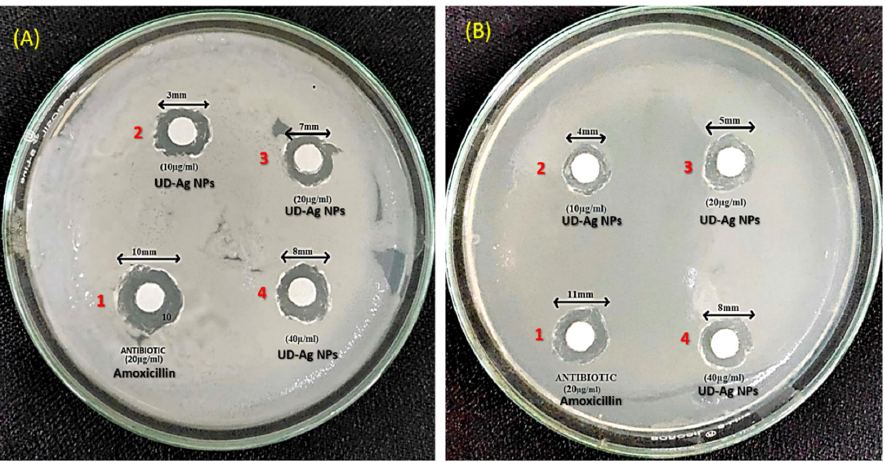
Figure 6. Antibacterial potential of AgNPs fabricated using the aqueous leaf fraction of U. dioica against Escherichia coli ( A ) and Pseudomonas putida ( B ) bacterial strains. Note: 1 = Antibiotic (Amoxicillin